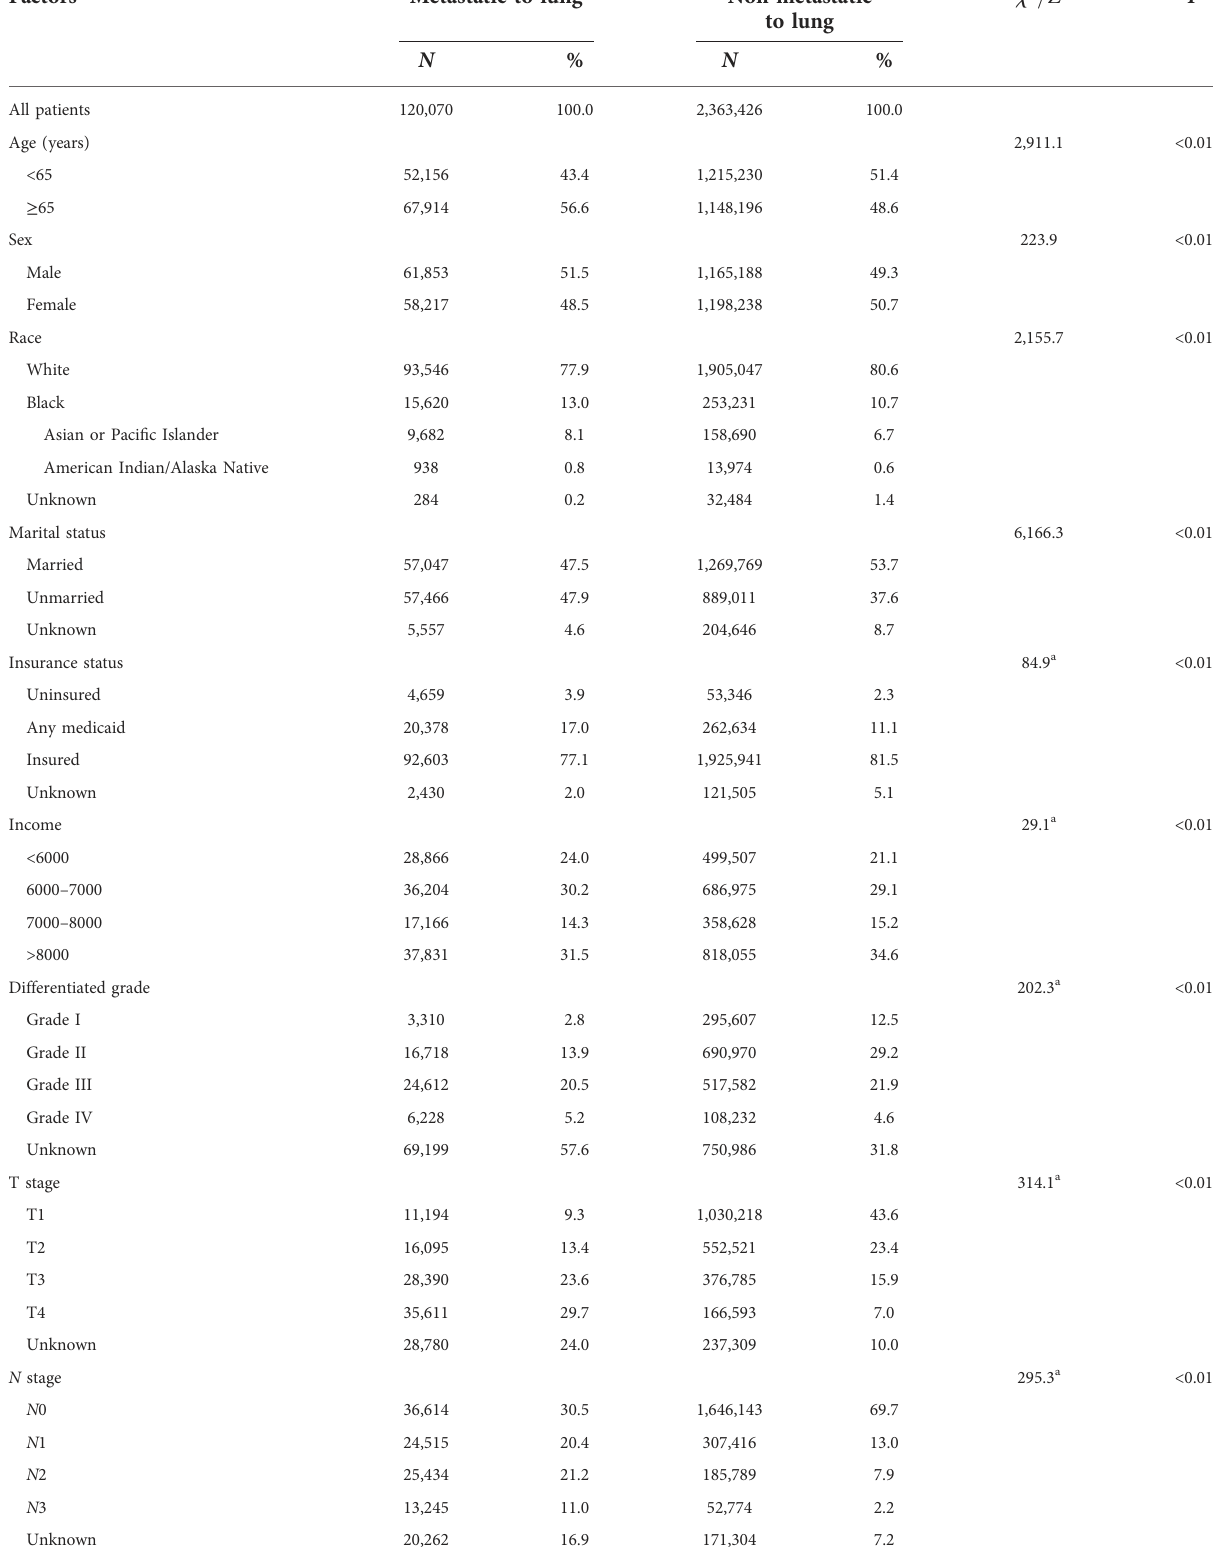
TABLE 1A Demographic and clinical characteristics distribution of the included patients in the research